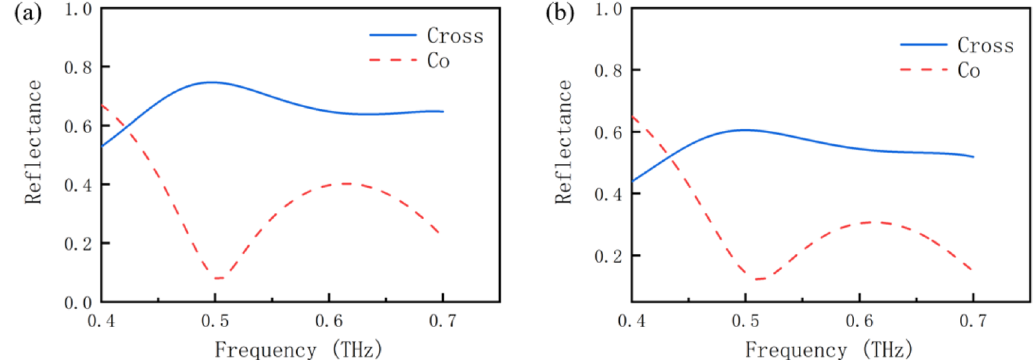
Fig. 5. Simulation re fl ectance coef fi cient curve of meta-atoms. Simulation result when (a) s =20 000 S/m and (b) s = 10 000